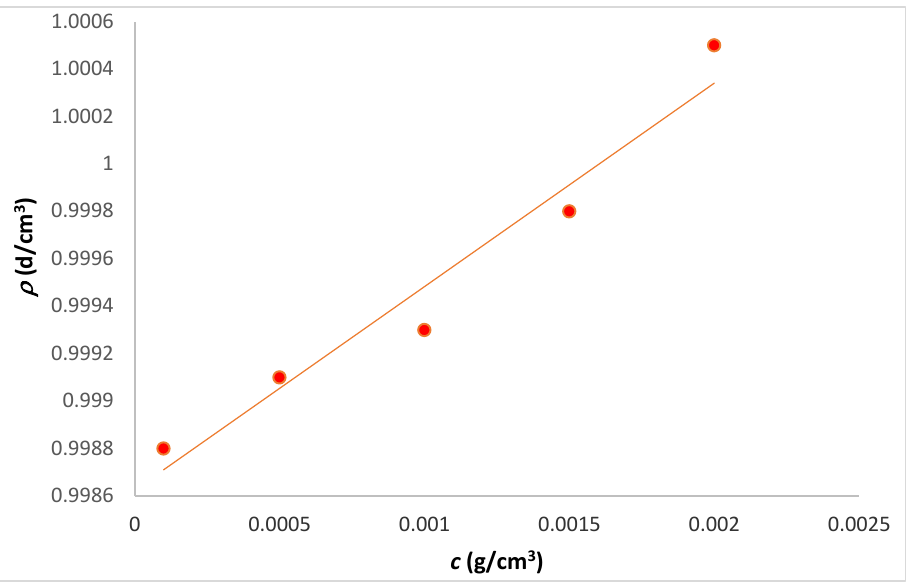
Figure 2. Density in function of concentration ( ρ vs. c ).